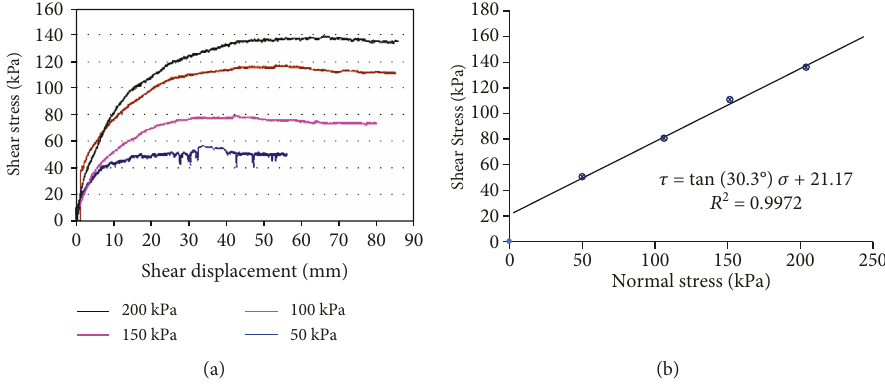
Figure 13: Shear stress-displacement curve and strength parameters of the fi rst